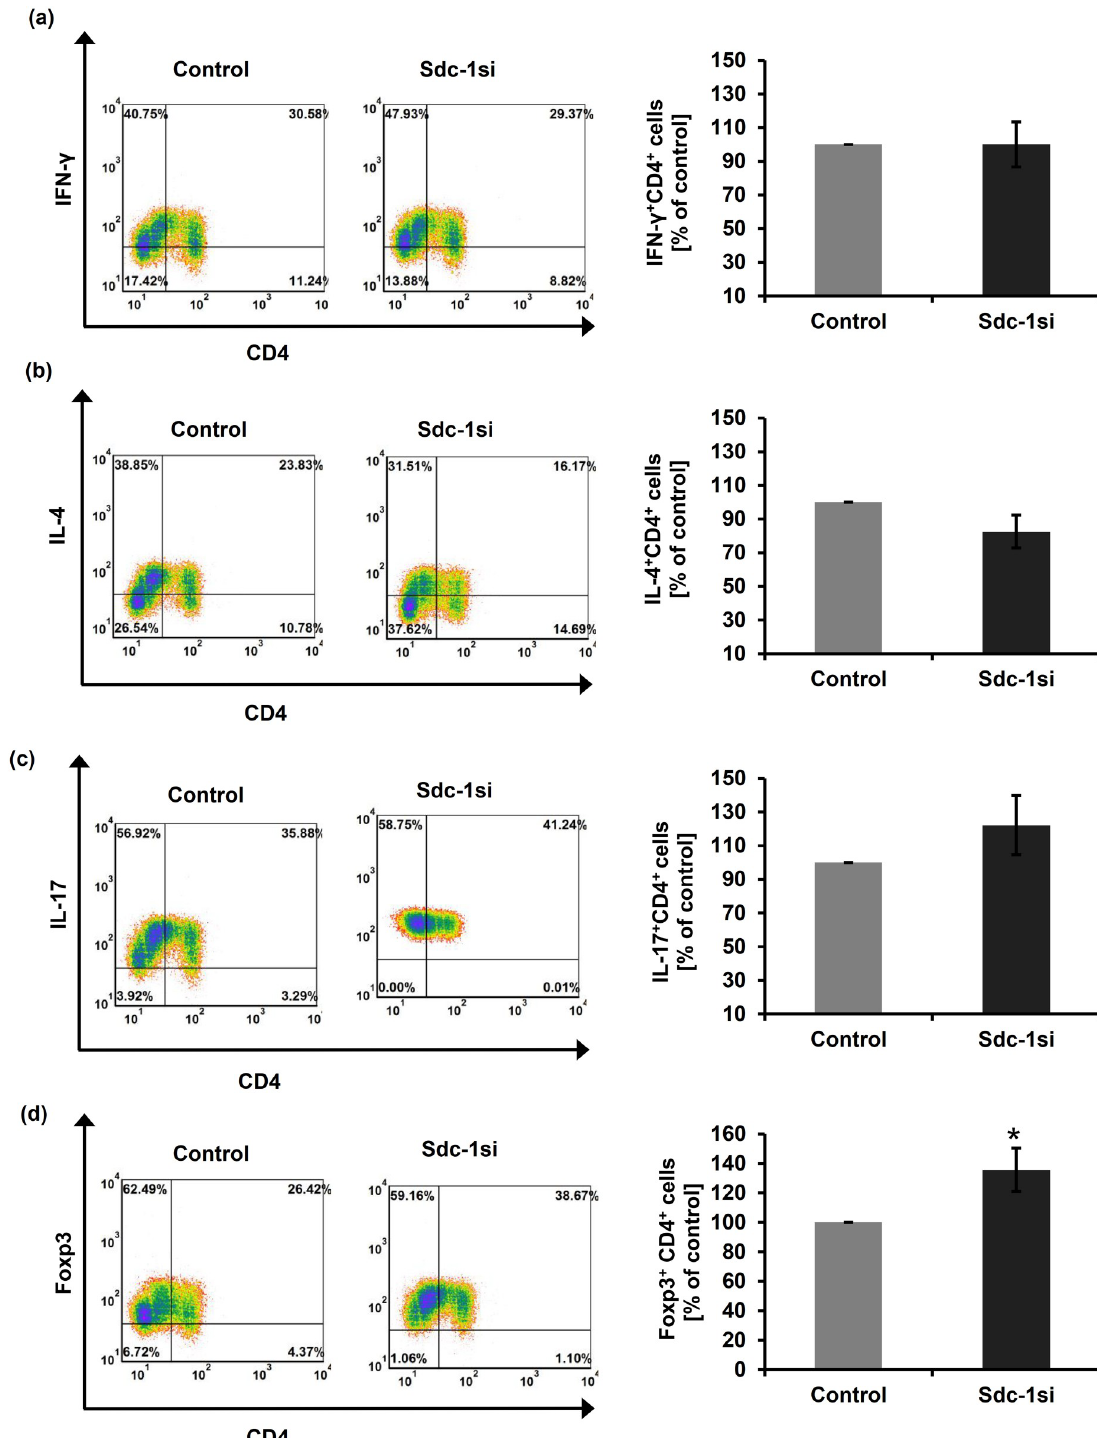
Fig 3. Flow cytometric analysis of normal T helper subsets upon direct co-culture with Sdc-1-silenced SUM-149 cells. PBMCs isolated from normal subjects were co-cultured with Sdc-1-silenced SUM-149 cells for 48 hours. Lymphocytes were then stained with labeled antibodies against CD4-FITC, IFN- γ -PE, IL-4-PEcy7, IL-17-PE, and Foxp3-PEcy7. Relative to control cells, tumor Sdc-1 silencing significantly increased the percentage of (d) T reg (Foxp3 + CD4 + ) subsets while did not change the percentage of the other CD4 + T cell subsets (a-c) . Left panels of (a-d) are representative flow cytometric analyses of CD4 + T cell subsets. Data shown is representative for a single experiment. Right panels of (a-d) show the quantification of CD4 + T cell subsets as analyzed by flow cytometry. Data represent mean ± SEM, n = 5, � P � 0.05 as determined by Student’s t test. https://doi.org/10.1371/journal.pone.0217550.g003 PLOS ONE | https://doi.org/10.1371/journal.pone.0217550 May 30,